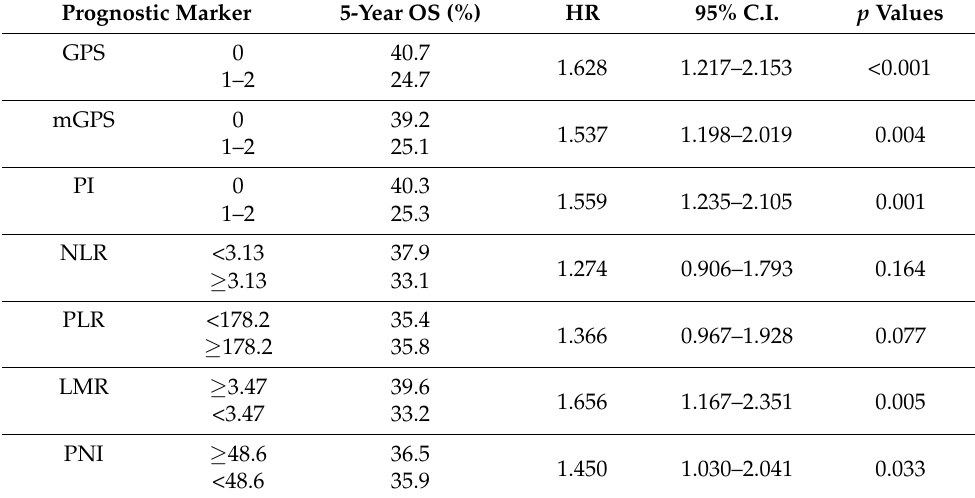
Table 3. Univariate analysis and cox logistic regression analysis for overall survival of the inflamma- tory based and nutritional prognostic markers.